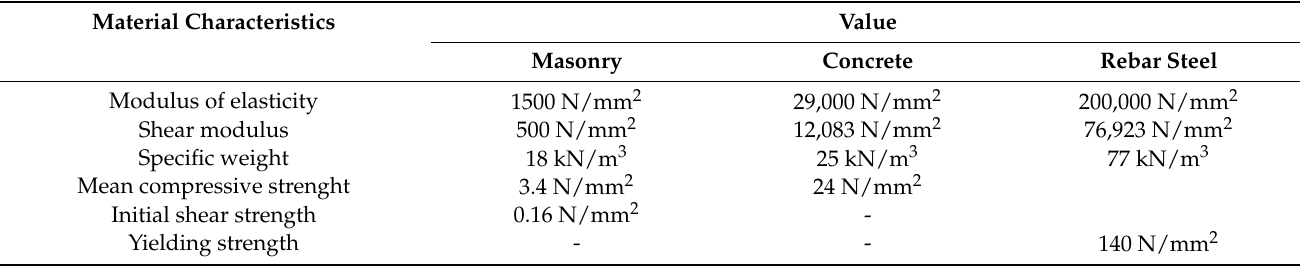
Table 1. Mechanical properties of the materials.